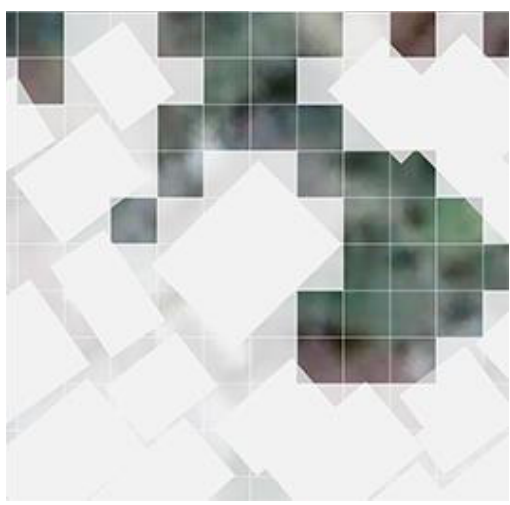
Figure 4: Cells selected with a buffer of -0.8m in white